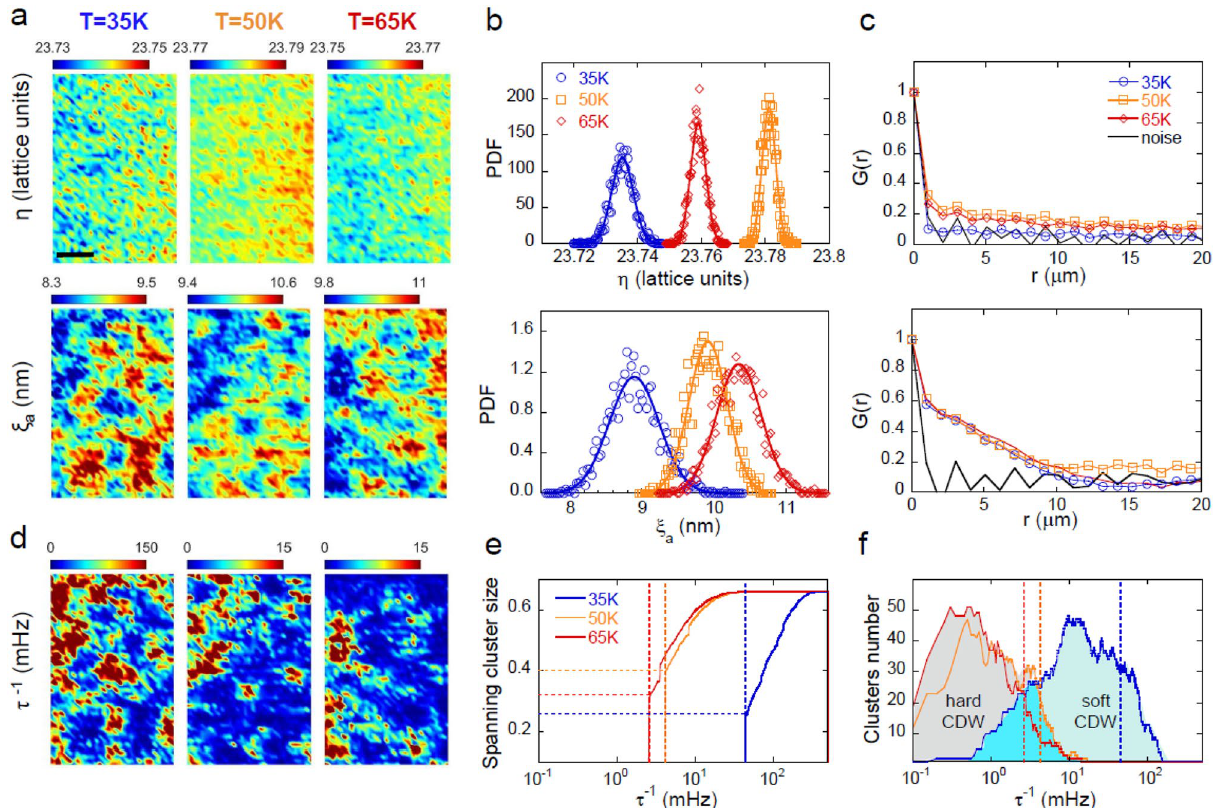
Figure 3. Mapping the small/large and fast dynamics CDW domains by X-ray micro diffraction in La 1.71 Sr 0.29 NiO 4 . ( a ) Maps ( b ) PDF and ( c ) G(r) of CDW peak incommensurability, η, in plane coherence length, ξ a , measured at T = 35 K, 50 K, and 65 K. Values of each single pixel have been obtained recording the CDW peak in a specific (x, y) position of the sample. In order to reconstruct the spatial maps, the sample has